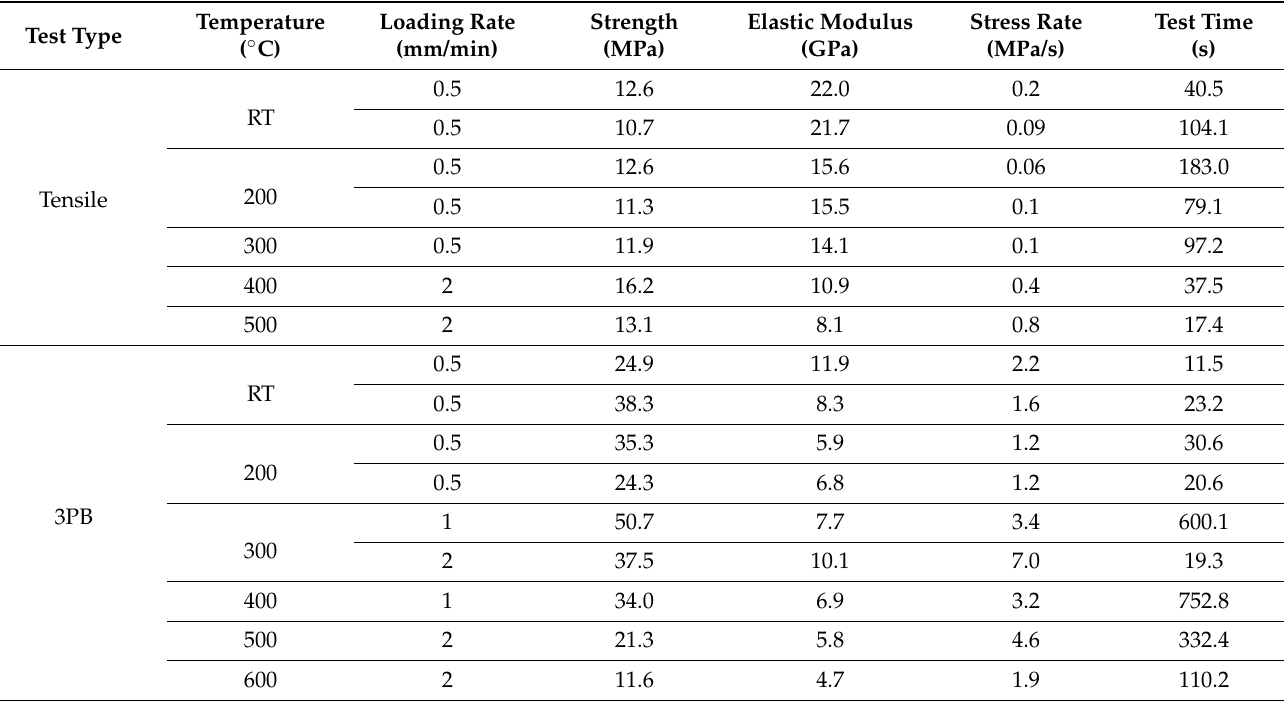
Table 1. Test temperature, loading rate, strength, elastic modulus and stress rate of the tensile specimens and 3PB